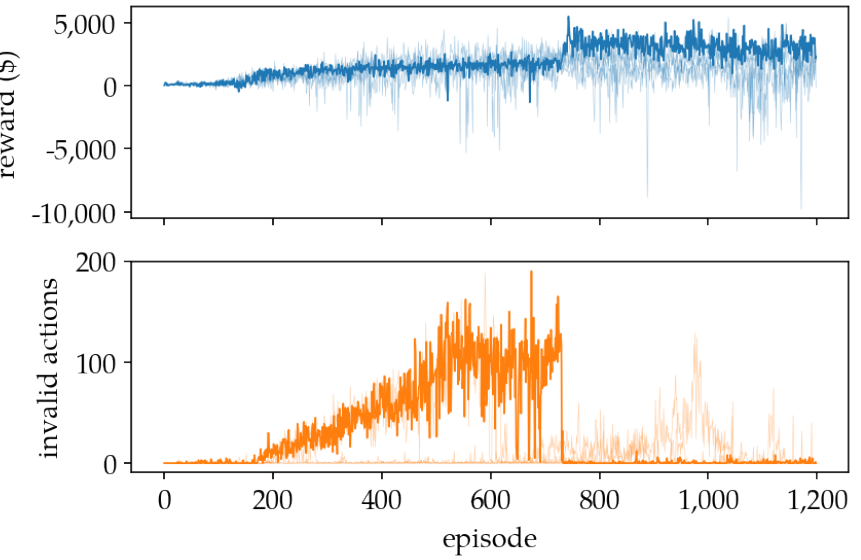
Figure 9. Training curves of the proposed model, with the best of five runs being highlighted.